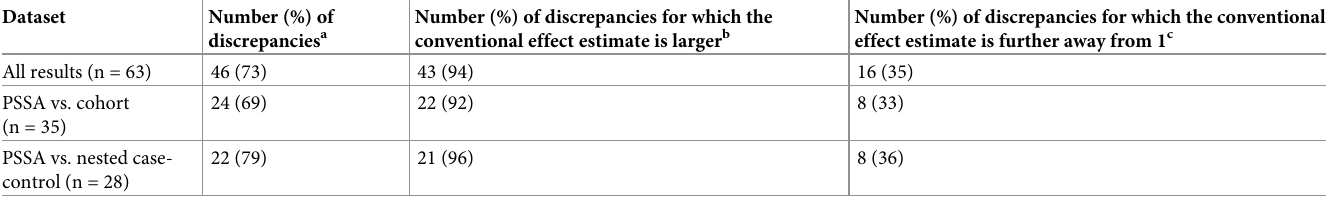
Table 3. Number of discrepancies between PSSA and parallel group designs. Dataset Number (%) of discrepancies